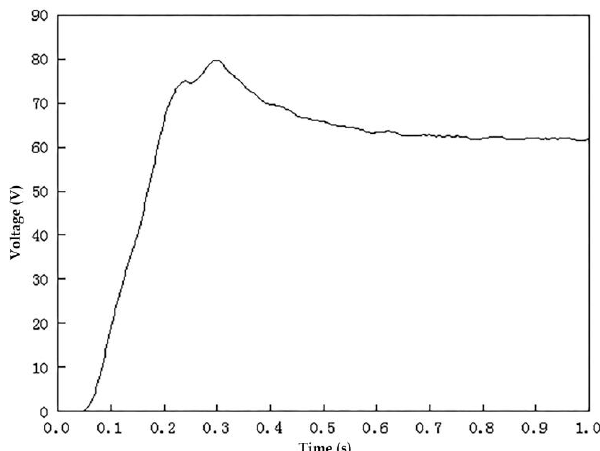
Figure 20. The filtered capacitor of 1800 uF is connected at the load end, the filtered generation voltage waveform is shown in Figure 20.